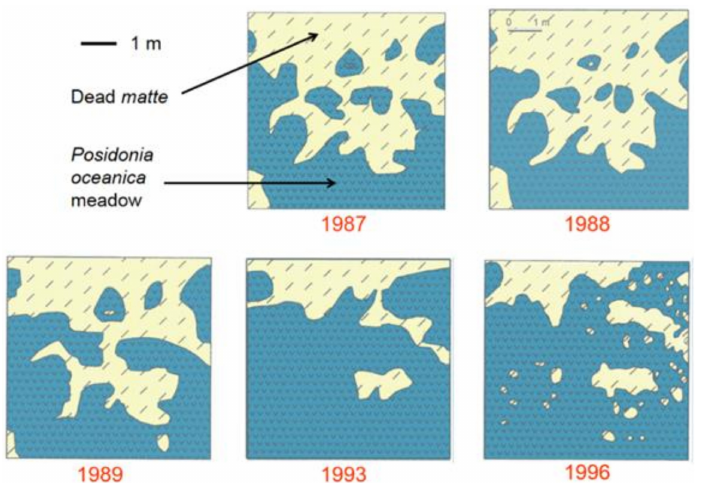
Figure 7. A permanent quadrat (5 m × 5 m) in Prado Bay, Marseille (France). The sewage water treatment plant was put in operation in 1987. From Gravez et al. [158],